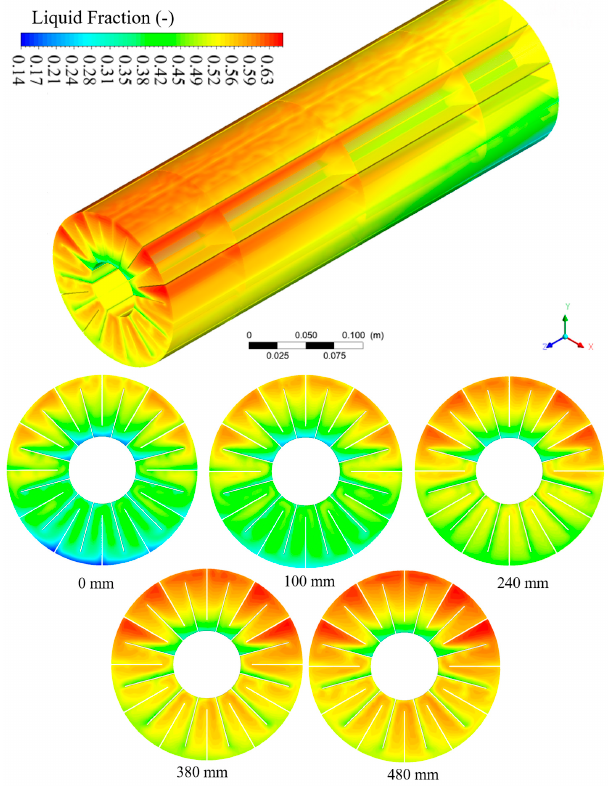
Figure 16. PCM liquid fraction distribution for 50% of volume in a liquid state (t = 6522 s).